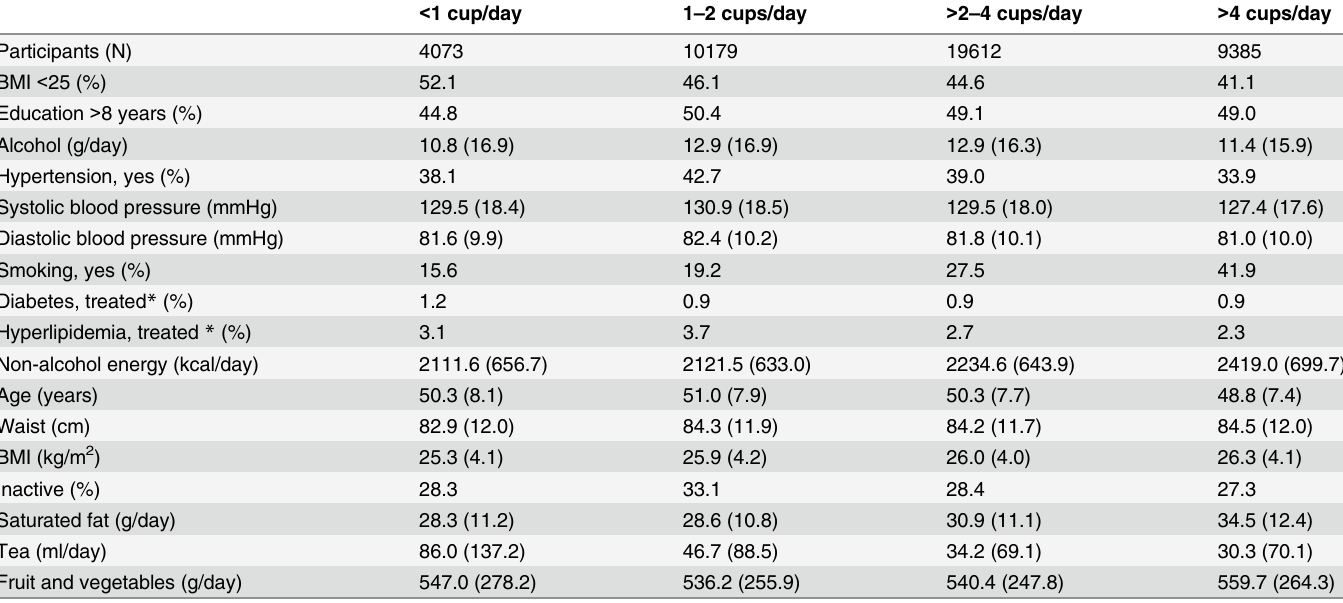
Table 1. Baseline characteristics of 43,249 EPICOR participants by coffee consumption. < 1